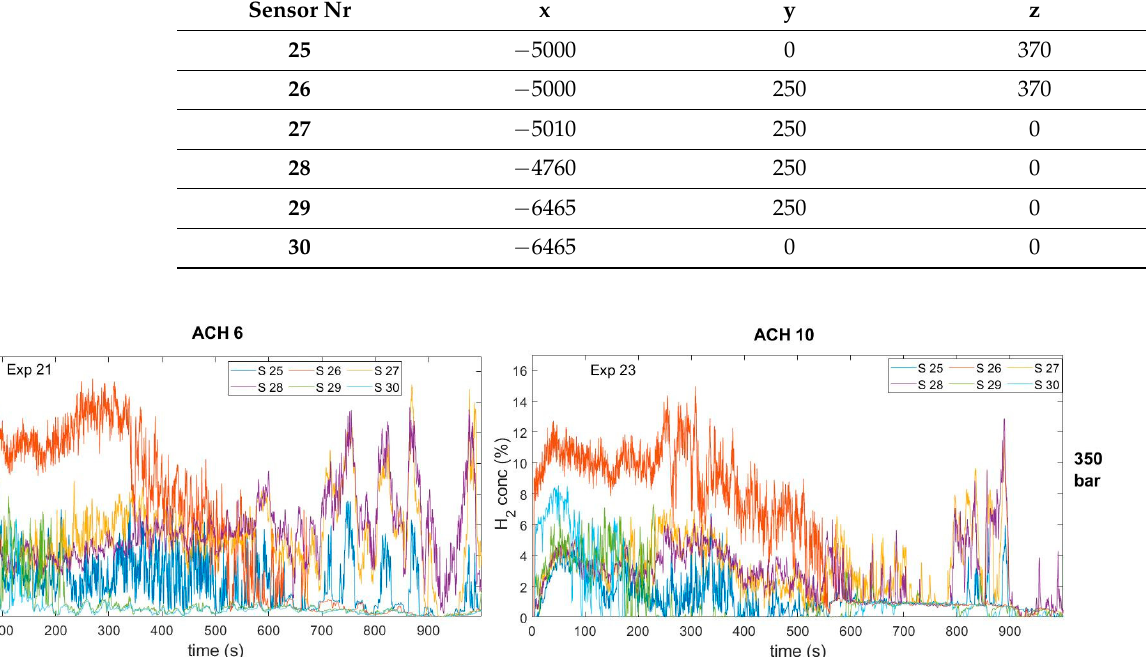
Table 4. Hydrogen sensor location under the car.